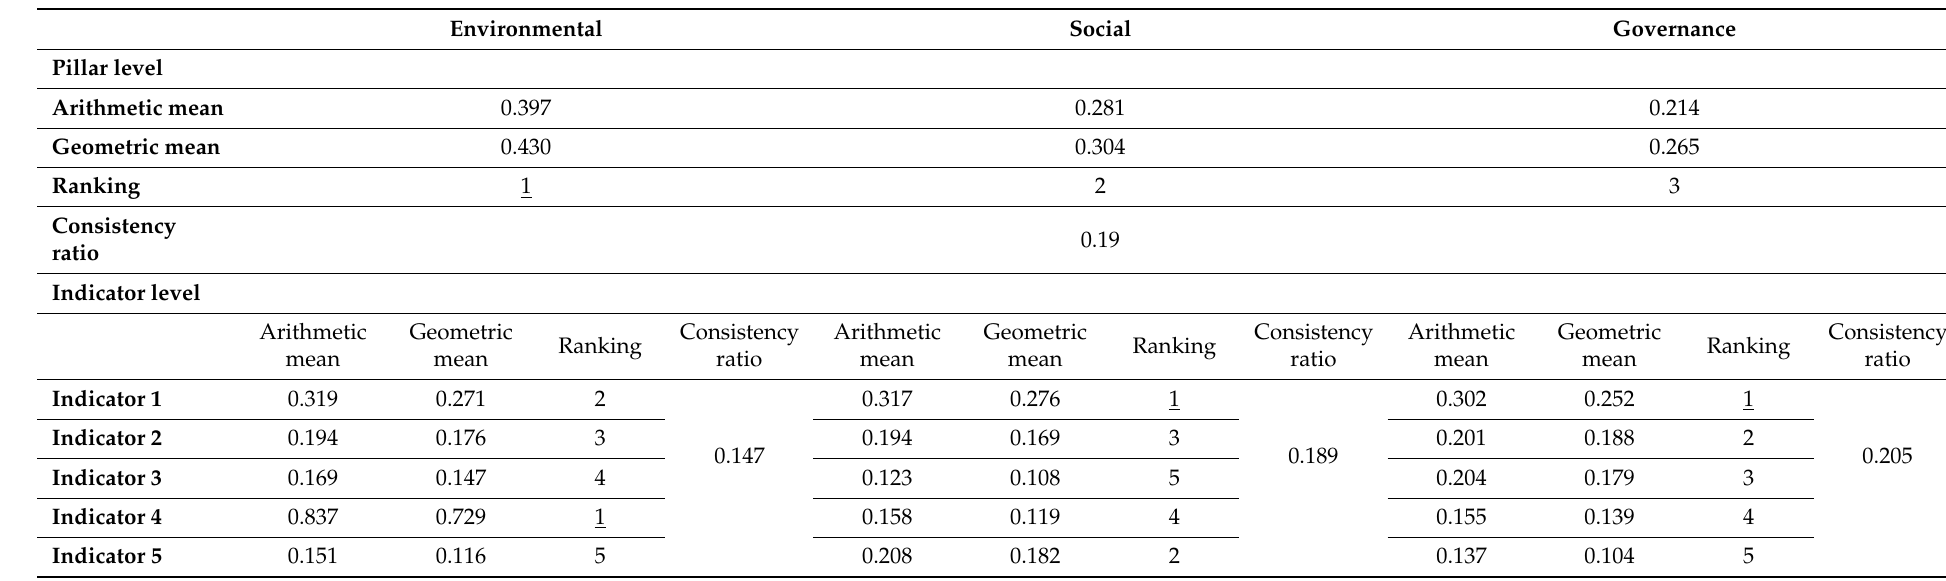
Table 5. AHP weights and consistency ratios at pillar and indicator